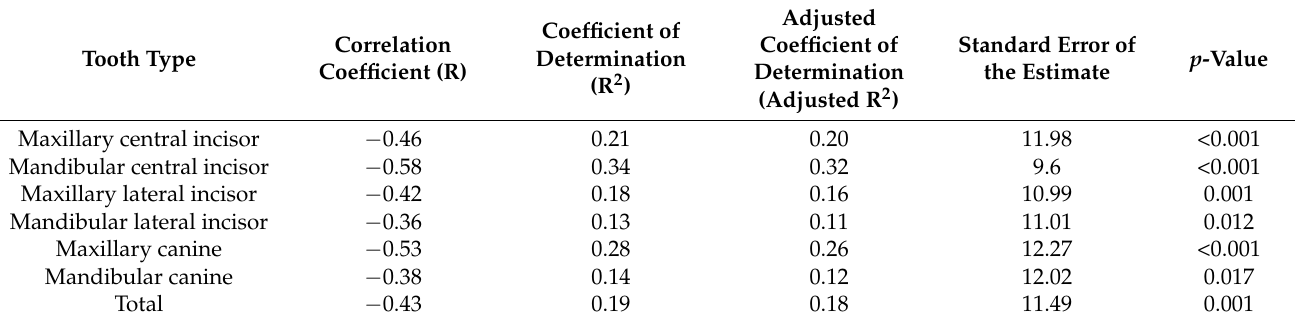
Table 5. Linear regression results predicting age based on pulp–tooth ratio.